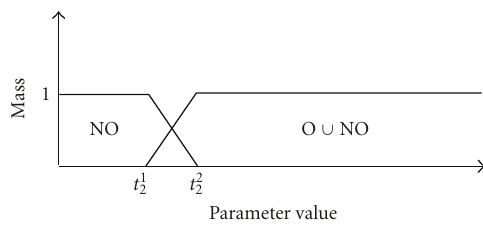
Figure 8: Definition of the mass functions for the higher-order statistics (the graphic is valid for definition of t 1 3 and t 2 3